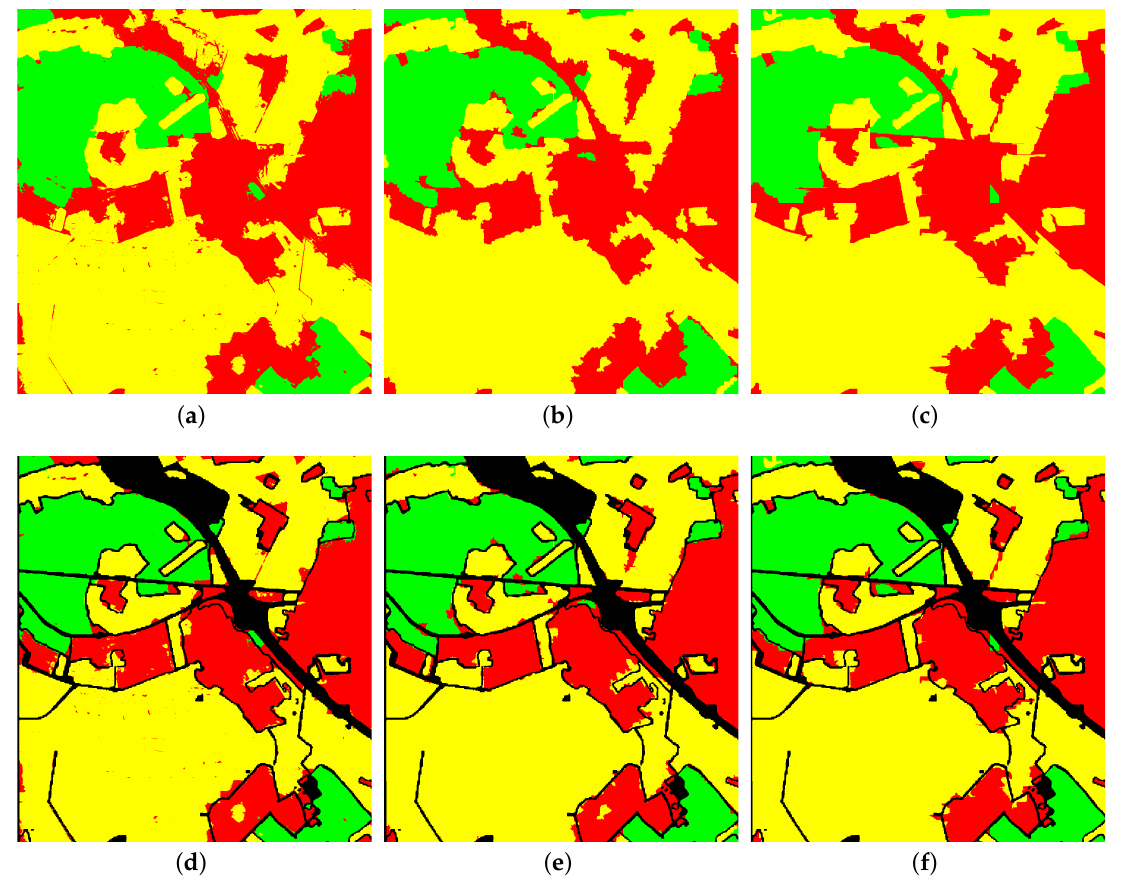
Figure 21. he visual classification results on Oberpfaffenhofen data set. ( a ) The classification map by QSLIC. ( b ) The classification map by QSEEDs. ( c ) The classification map by QPAN. ( d ) The classification map ( a ) overlaid with the ground truth map. ( e ) The classification map ( b ) overlaid with the ground truth map. ( f ) The classification map ( c ) overlaid with the ground truth map.